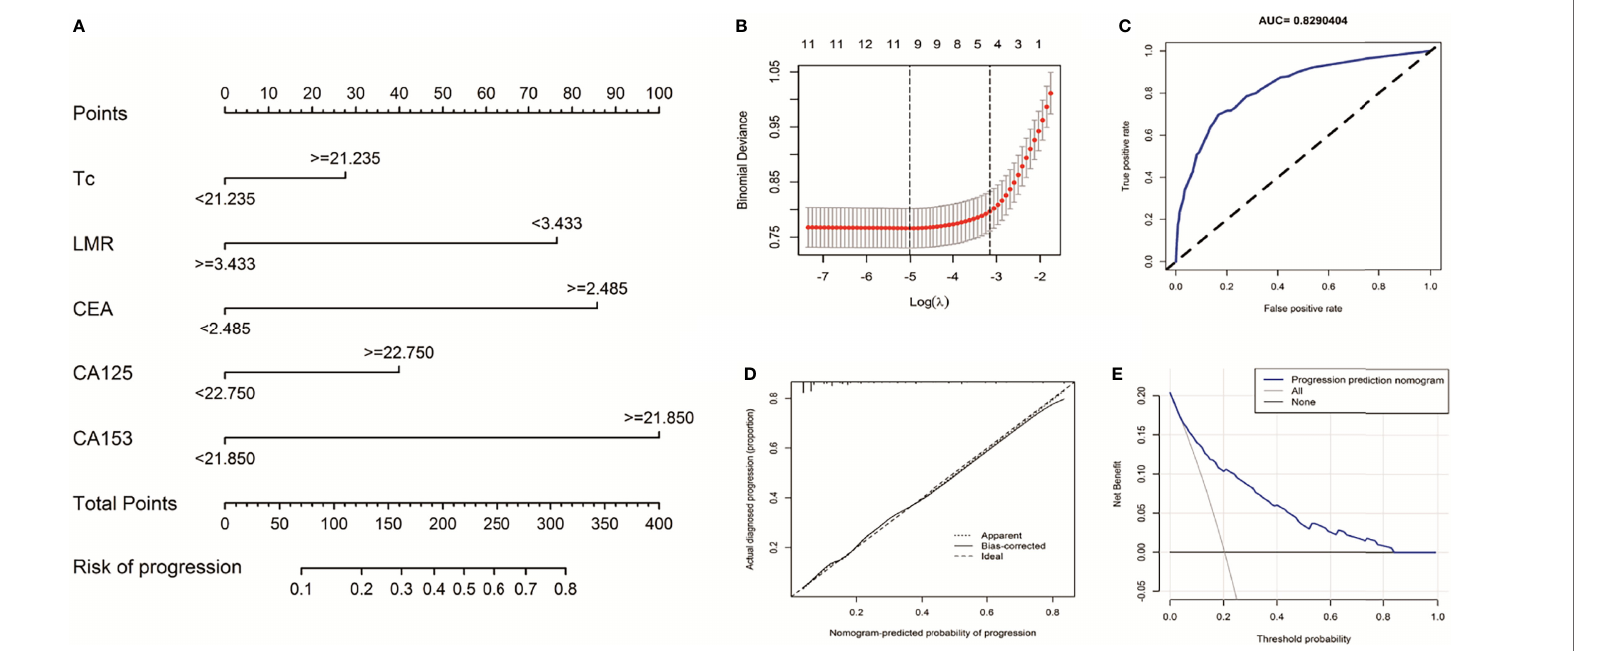
FIGURE 4 | Nomogram for prediction of BC metastasis risk. (A) shown is the Nomogram for predicting the risk of stage IV based on Multivariate logistic regression analysis in BC patients. (B) Selection results of the LASSO model. The partial likelihood deviance (binomial deviance) curve plot versus log l . Dotted vertical lines draw at the optimal values by using the minimum criteria. (C) Plotted is a ROC curve for the independent validation cohort of the logistic regression model used in the Nomogram. The AUC is denoted, with the closer to 1, the better the model is. (D) the calibration plot gives the prediction performance of the proposed Nomogram in the discovery cohort, with the closer to the 45° line, the better the performance. (E) Decision curve analysis for the risk nomogram. The X-axis is the risk threshold probability that changes from 0 to 1, and the Y-axis is the calculated net bene fi t for a given threshold